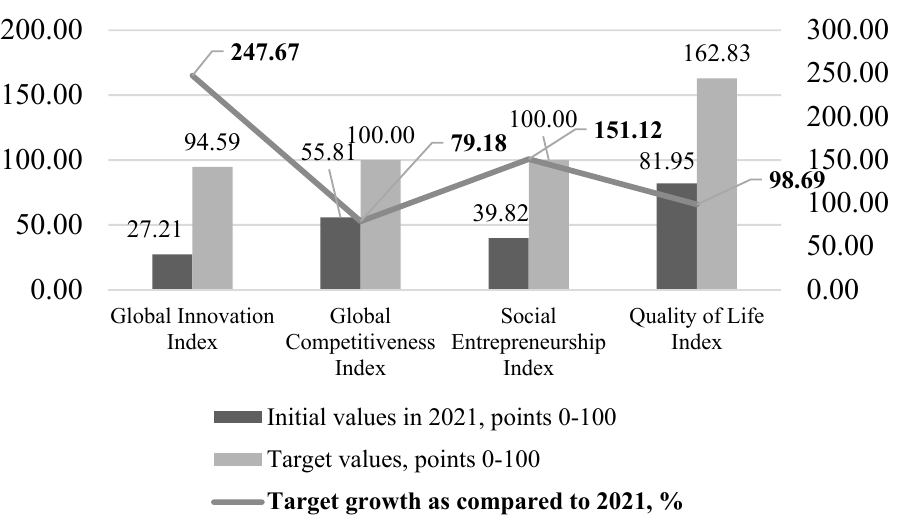
Figure 2. Perspectives of improving the practice of managing the risks of innovative activities focused on the consumer market in countries with lower middle income. Source: Calculated and compiled by the authors.